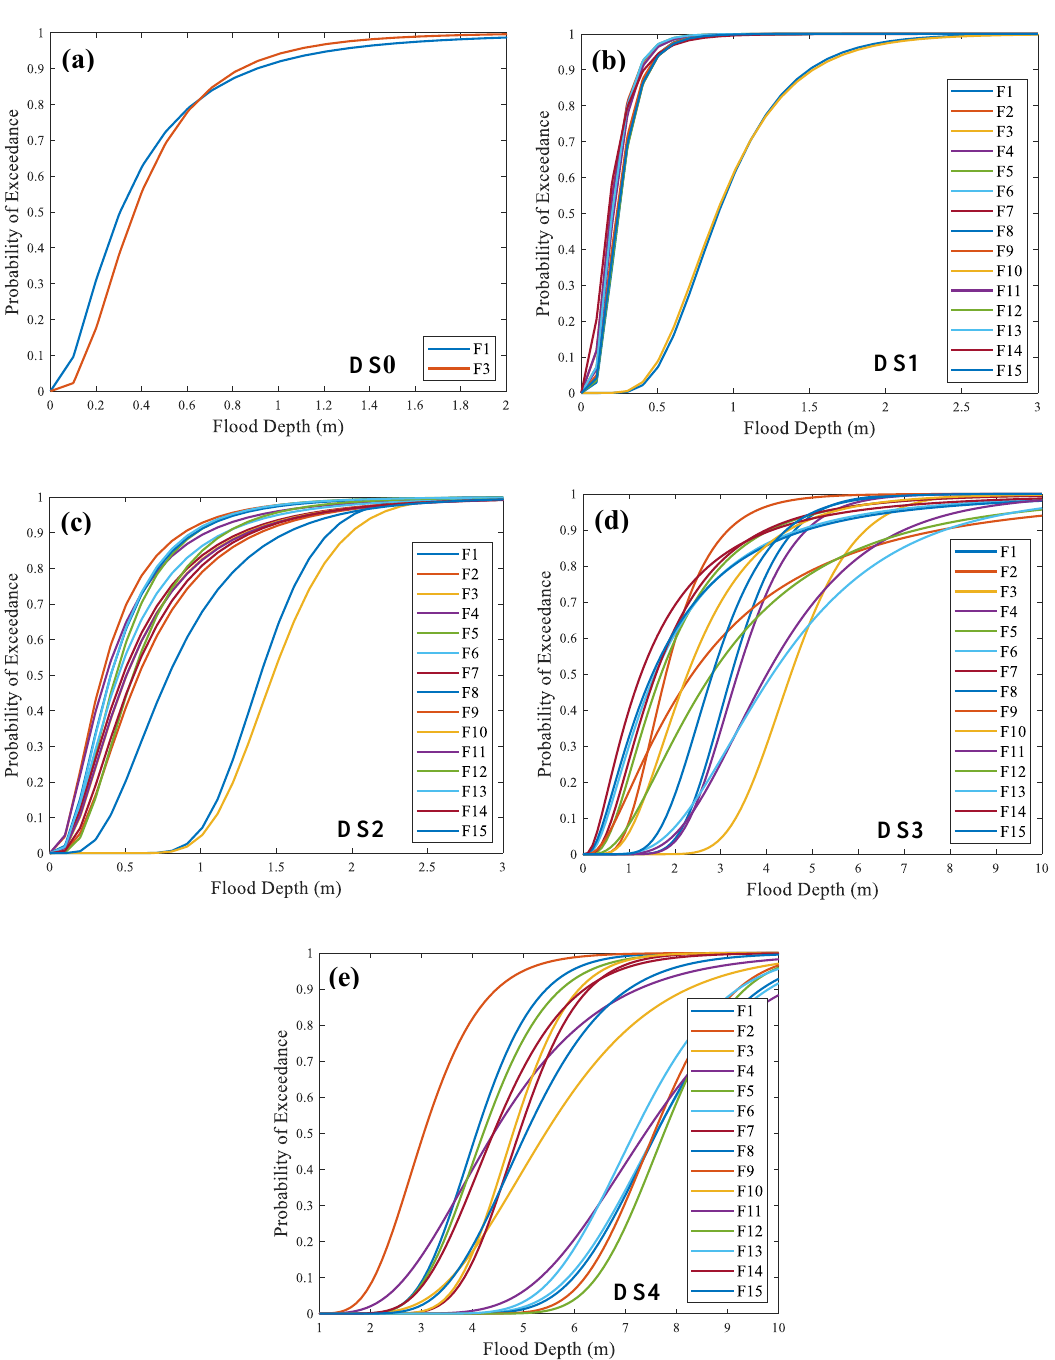
Figure 8. Building archetypes’ fragility curves: ( a ) DS0; ( b ) DS1; ( c ) DS2; ( d ) DS3; ( e ) DS4.